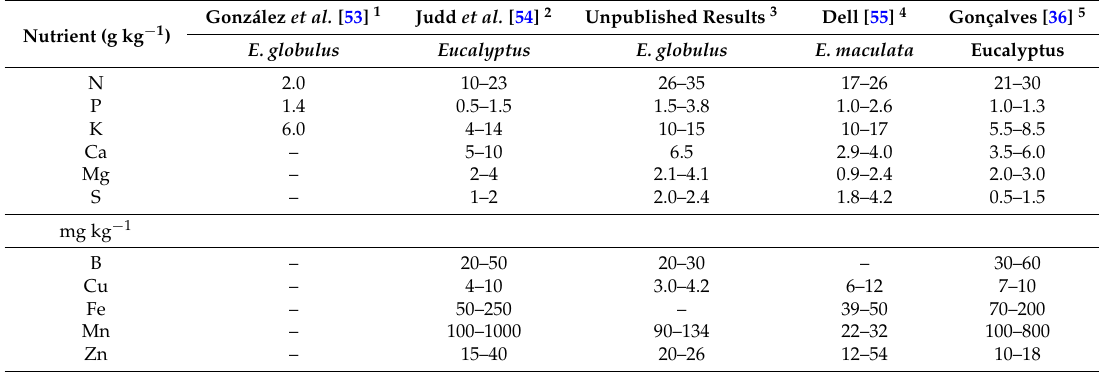
Table 3. Range of nutrient concentrations in eucalyptus leaves.